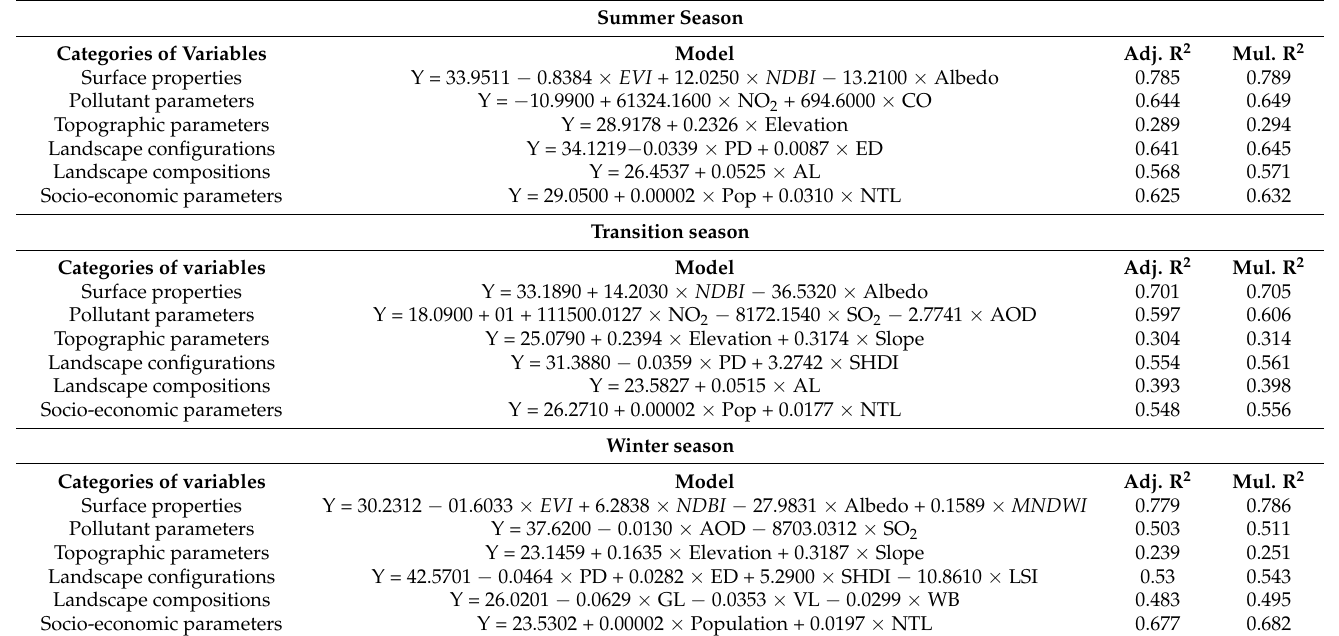
Table 7. Results of optimum regression model for each category of variables in different